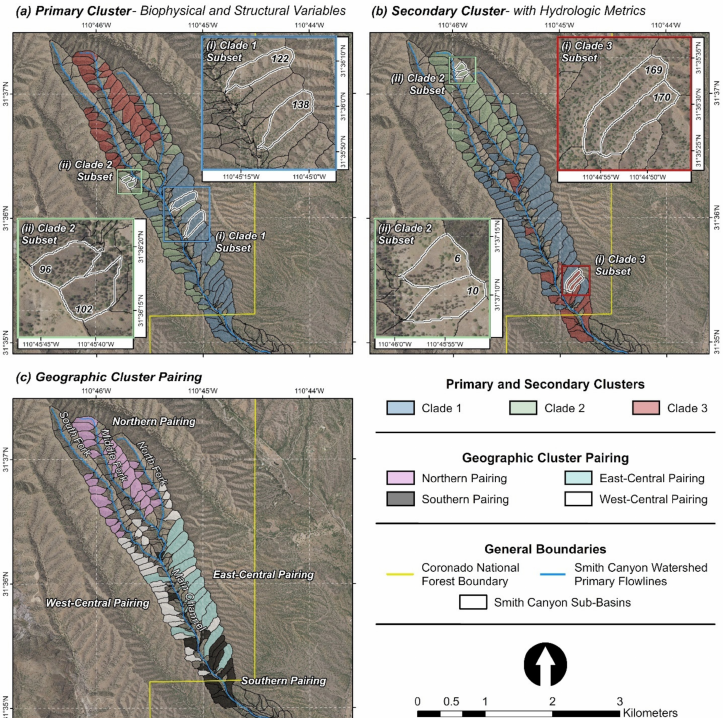
Figure 8. Maps showing the geographic distribution of the three clades derived in the hierarchical clustering analysis for ( a ) the primary cluster, and ( b ) the secondary cluster, as well as ( c ) areas of overlapping clusters. Subsets (i and ii) show selected paired watersheds within specific clades. An aerial orthophoto from the National Agricultural Imagery Program (NAIP) was used as back- ground imagery. Table 4. Showing mean values of the selected, ( a ) structural, ( b ) biophysical, and ( c ) hydrologic variables for each of the geographic cluster pairings. Highest values are bolded while the lowest values are italicized. (a) Structural